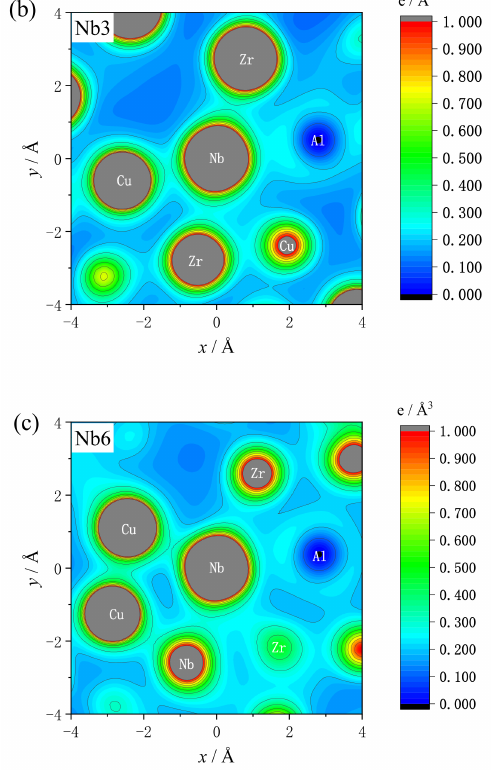
Figure 7. Free electron density contours of amorphous alloy clusters simulated by AIMD at 300 K: ( a ) Al-centered in Nb0; ( b ) Nb-centered in Nb3 and ( c ) Nb-centered in